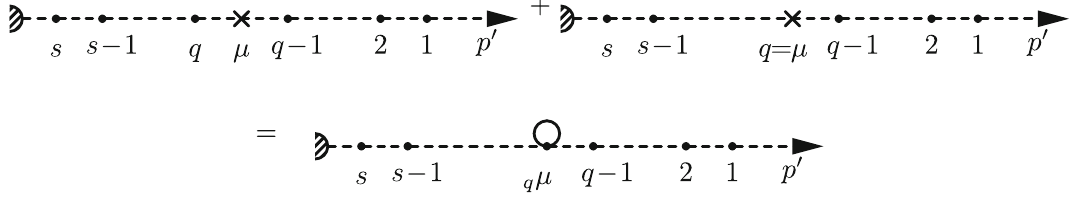
Fig. 4 Combining the two possible sets of insertions (as in Figs. 2 and 3) of the ( n + 1 ) th virtual K photon at the vertex μ on the p (cid:8) leg to give a single circled vertex, q μ ; see text for details. The photon lines have been suppressed for clarity of inserting both A and B types of vertices in all possible ways on the p (cid:8) leg